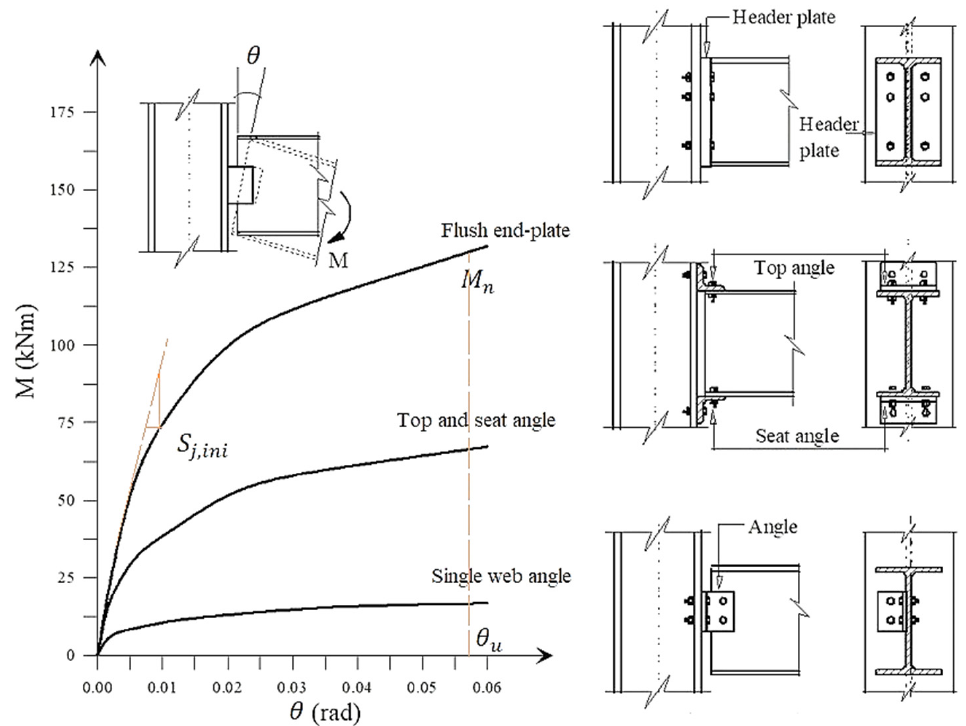
Figure 2. Moment–rotation curve of common types of beam-to-column connections (adapted from [5] under the terms and conditions of a Creative Commons Attribution License (CC BY)).